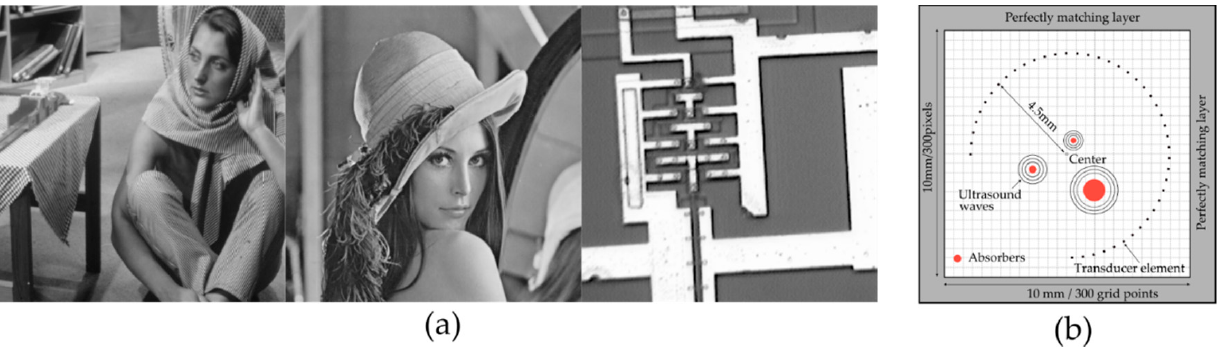
Figure 1. Standard test images: Barbara, Lena and Circuits ( a ). k-Wave simulation setup ( b ).